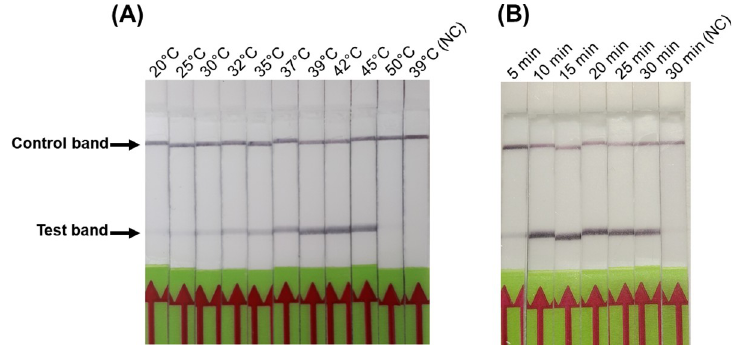
Fig 3. Optimization of temperature and time for M . ovipneumoniae RPA-LFD assay. (A), The RPA amplification was performed at temperatures ranging between 20˚C and 50˚C and was operative between 30˚C and 45˚C. (B), Evaluation of amplification time for the RPA assay where the amplification was performed for various time ranging from 5 to 30 min at 39˚C. Amplified dual-labelled amplicons were run on LFD and the positive signal be detected as early as 2 min. Negative control (water) did not produce any